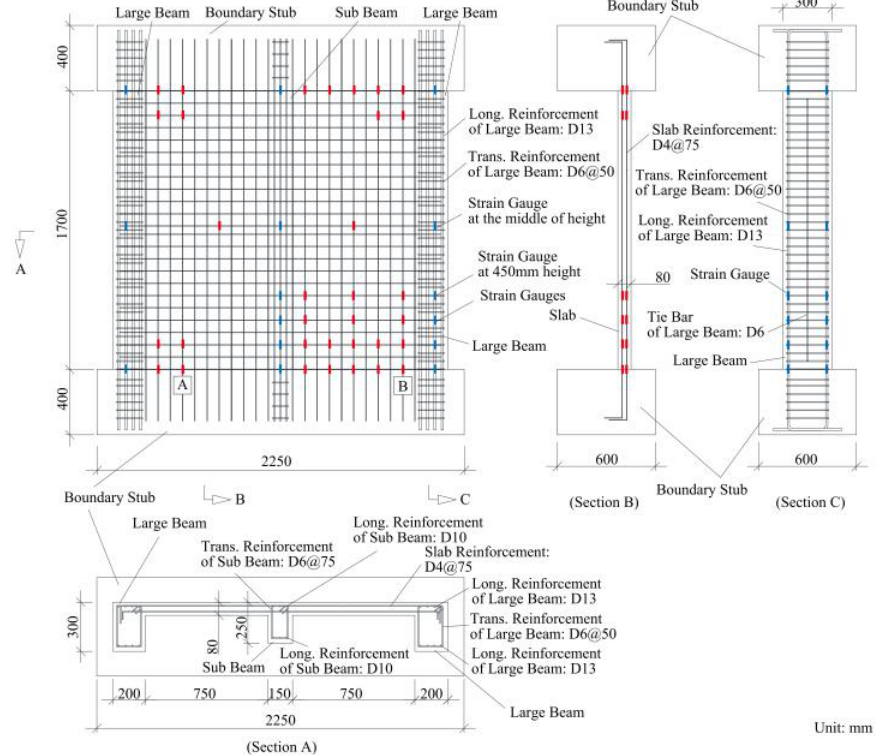
Figure 1. Schematic of the